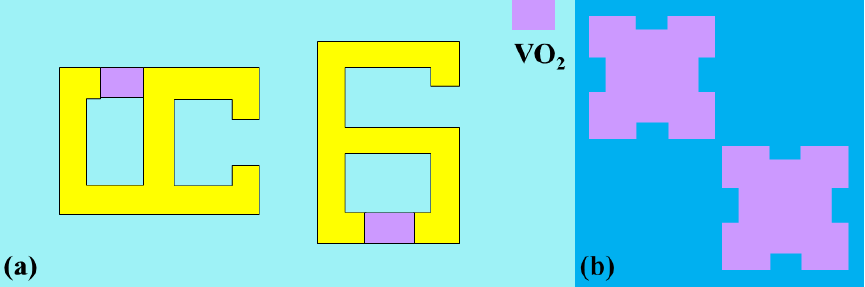
Figure 10. VO 2 -based metamaterial absorber structures. ( a ) Split-ring metal resonators with embed- ded VO 2 material [138]; ( b ) two VO 2 patterns [147].